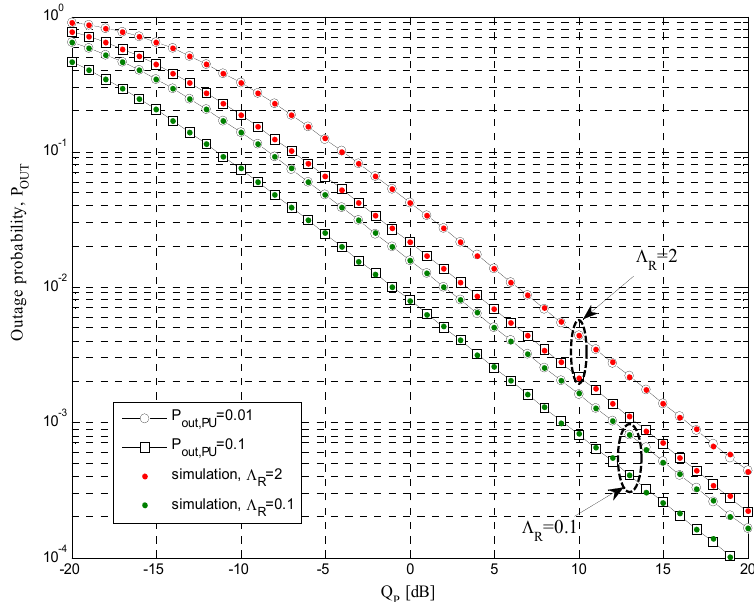
Figure 4. Outage probability P OUT vs. Q p for TSR protocol.